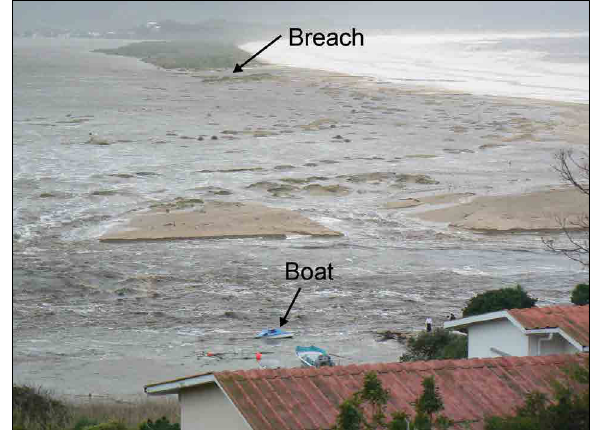
Figure 11: Photo taken at the time of the breach of the barrier dune (see Figure 9). The photo was taken from the square on Sydney Street depicted in Figure 7, October 2011.